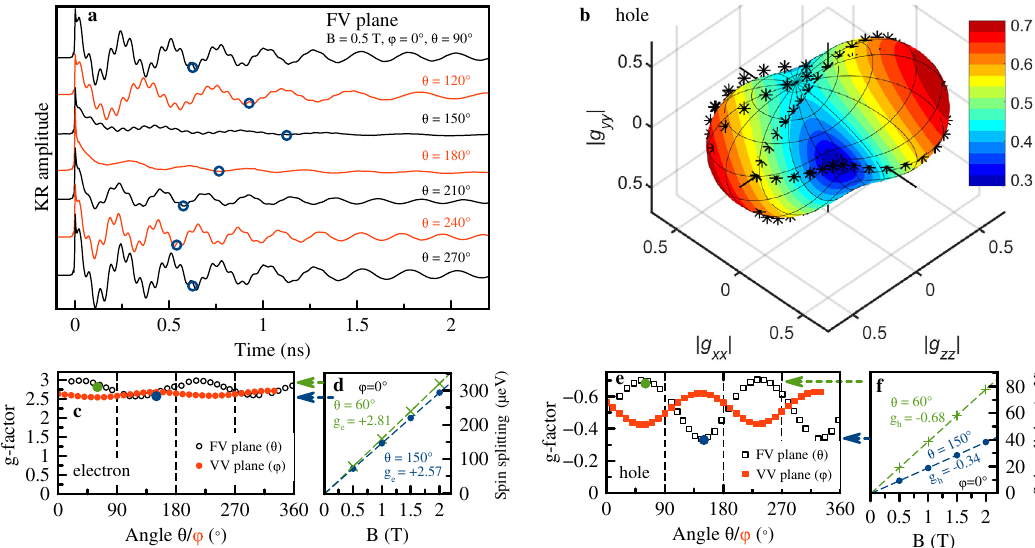
Fig. 4 Pump-probe Kerr rotation in MAPbI 3 . a TRKR signals in magnetic fi elds of 0.5 T rotated in the Faraday-Voigt plane ( φ = 0 ∘ ). T = 7 K. The variation of the hole Larmor frequency is indicated by the open circles. b Three-dimensional presentation of the hole g -factor tensor. Stars are experimentally measured values. The contour is a fi t to the data using Eq. (4). c , e Angular dependencies of the electron and hole g -factors for the magnetic fi eld rotated in the Faraday-Voigt (open symbols) and Voigt-Voigt (closed symbols) planes. d , f Magnetic fi eld dependencies of the electron and hole Zeeman splittings evaluated from their Larmor frequencies. Experimental data (symbols) are measured at θ = 60 ∘ and 150 ∘ ( φ = 0 ∘ ). Lines are linear fi ts. Table 1 Electron and hole g factors measured in the studied perovskite crystals at T = 1.6 and 5 K. Material